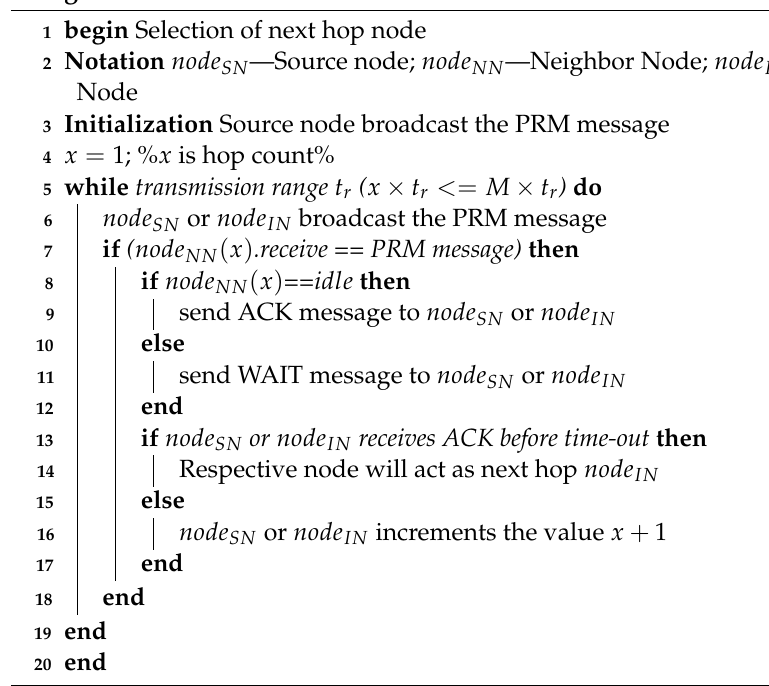
Algorithm 1: PRM-ACK based route formation.